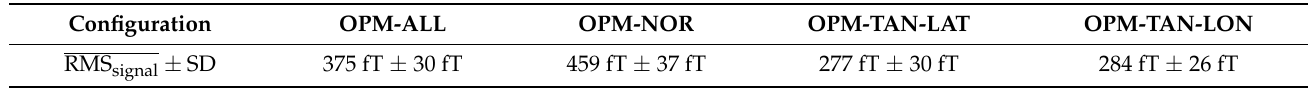
Table 1. The average RMS signal of the simulated MFM without noise for four different OPM-MEG con-